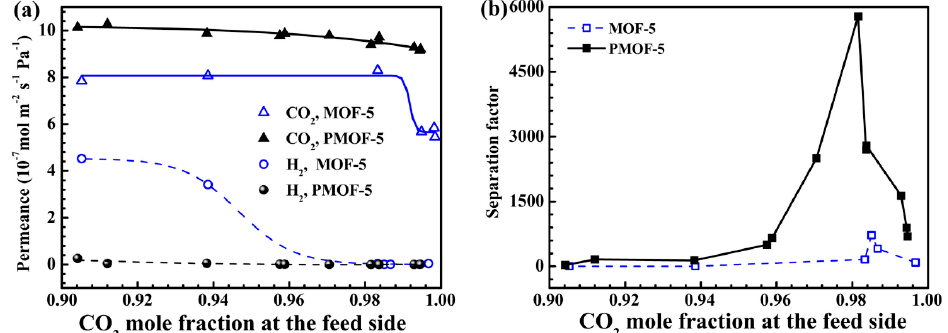
Figure 58. Performance comparison of MOF-5 and PMOF-5 membranes for CO 2 /H 2 gas mixture separation at 298 K and a feed pressure of 5 atm: ( a ) permeance and ( b ) separation factor (adapted with permission from ref. [151]).